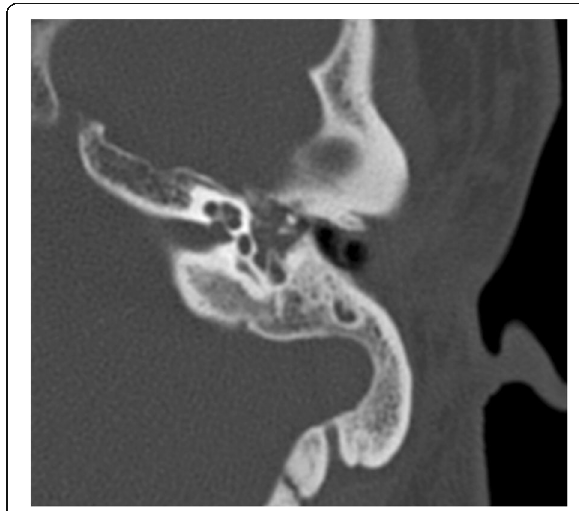
Fig. 6 Axial reconstruction of a temporal bone CT, at the level of the ossicular chain, of a 36-year-old Down syndrome patient demonstrating hypopneumatization of the mastoid and signs of left middle chronic otitis, with an erosion of the ossicular chain, namely the